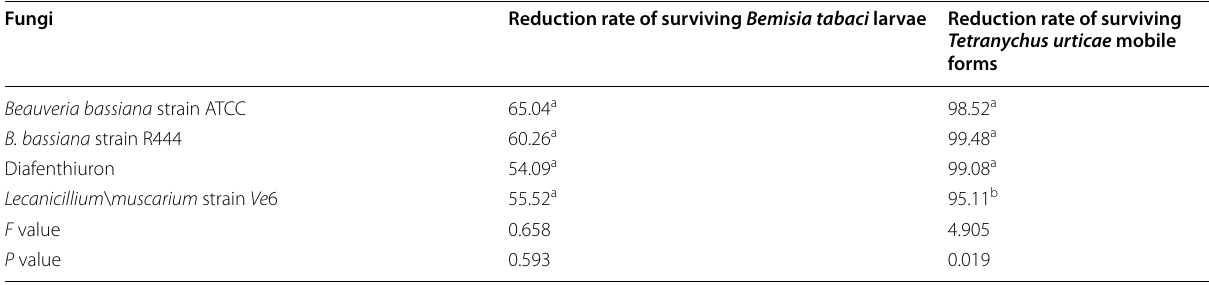
Different letters denote means are significantly different from one another, as determined by Duncan